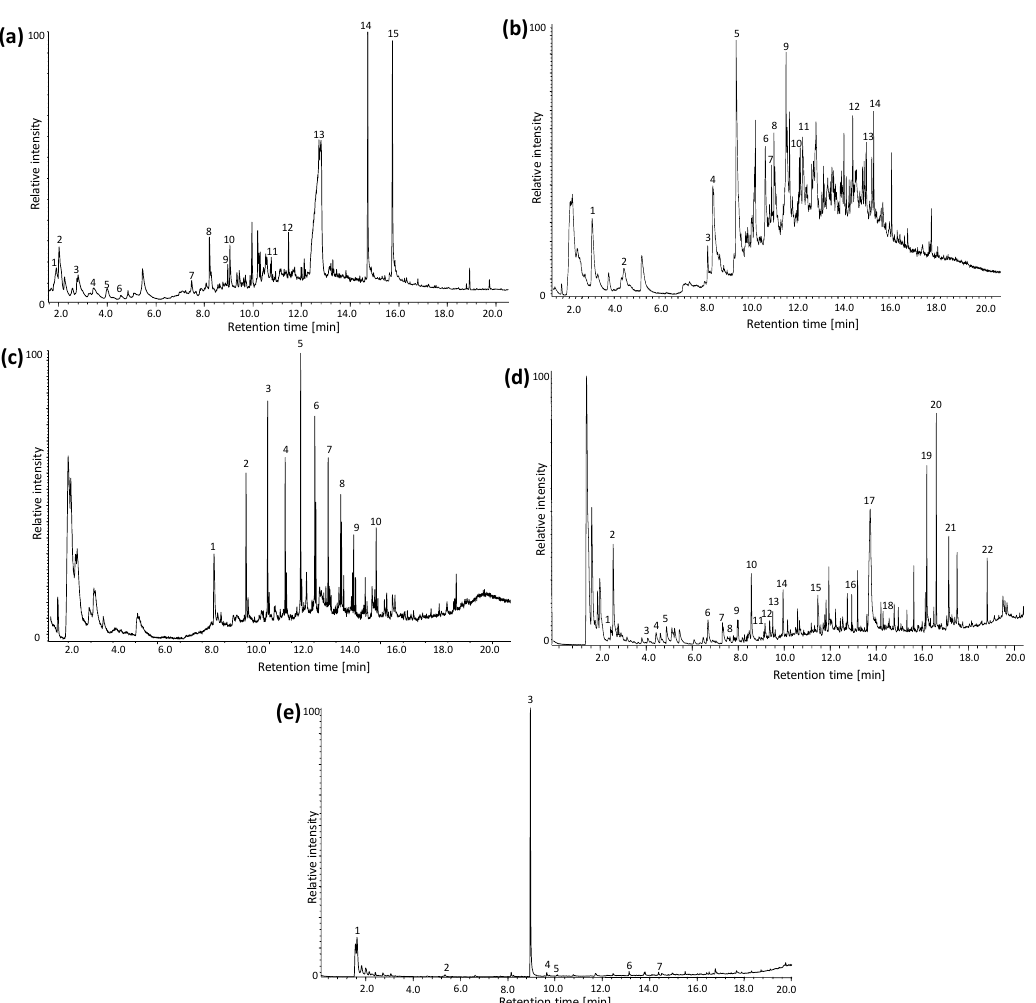
Figure 3. Pyrolysis Gas Chromatography Mass Spectrometry (Py-GC/MS ) pyrograms acquired for samples ( a ) C2, ( b ) C5, ( c ) C7, ( d ) C8, and ( e ) C11. The samples from the warp (sample C1) and from the black lace applied on the neckline of the costume (sample C2) were both identified as viscose upon OM observa- tion. The polysaccharide nature of the sample was highlighted by the infrared spectrum (Figure 2, IR spectrum of C2), showing an intense broad absorption band centered at 1024 cm − 1 (due to in-plane C-H bending of the ring) ascribable to carbohydrates [13,16,42]. The pyrolytic profile was mainly characterized by levoglucosan (labeled as #13 in Figure 3a for sample C2), furfural and furan derivatives (labeled as 1–12), which are characteristic pyrolysis product of a polysaccharide material [43]. The yellow hue of the warp is due to azoic dye Direct Yellow 28 (DY28; C.I. 19555; C 28 H 20 N 4 O 6 S 4 ), also detected in the yellow fiber of the volant and the lace applied on the sleeve (C3 and C7) and the corset (C4) (representative chromatograms will be shown in Section 3.2 for sample P). C3 and C4 were identified as cotton upon OM inspection. The difference between artificial fibers such as viscose (samples C1 and C2) and natural cotton fibers (samples C3 and C4) is clearly visible also in the SEM morphological images (both OM and SEM images are reported in Figure S1, Supplementary